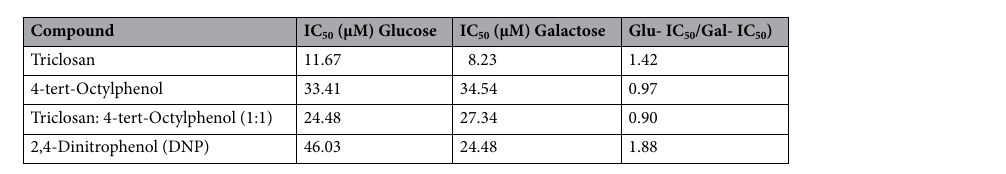
Table 2. IC 50 values of treated INS-1 cells in glucose- or galactose-containing culture medium.